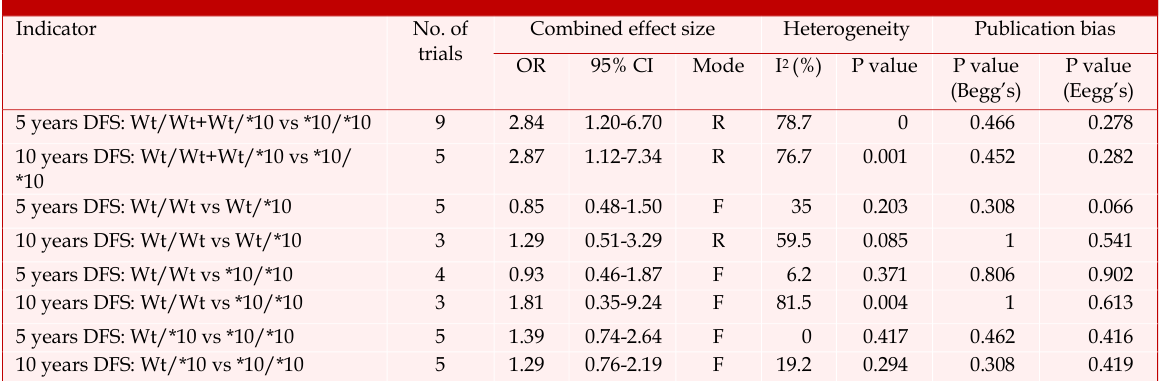
Meta-analysis on efficacy of DFS of breast cancer after the TAM treatment Indicator No. of